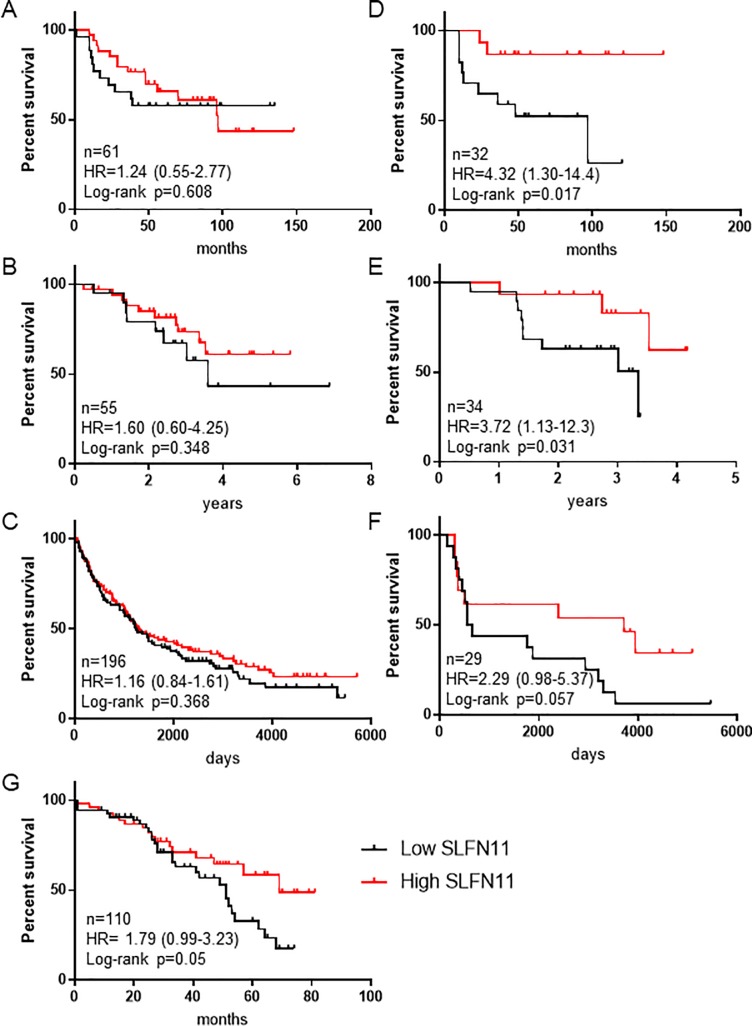
SLFN11 expression is associated with improved survival outcomes in breast, lung, and ovarian cancer patients treated with chemotherapy.RNA expression and survival data were obtained for primary breast, lung, and ovarian tumors from 4 datasets containing information from 61 breast cancer patients (A/D), 55 and196 lung cancer patients (B/E and C/F, respectively), and 110 ovarian cancer patients (G). Patients were dichotomized into High vs. Low tumor SLFN11 mRNA based on expression above or below the median. Survival analyses were performed for all patients in aggregate in (A-C), and only for patients who received chemotherapy (D-G). Groups were compared by log-rank test.